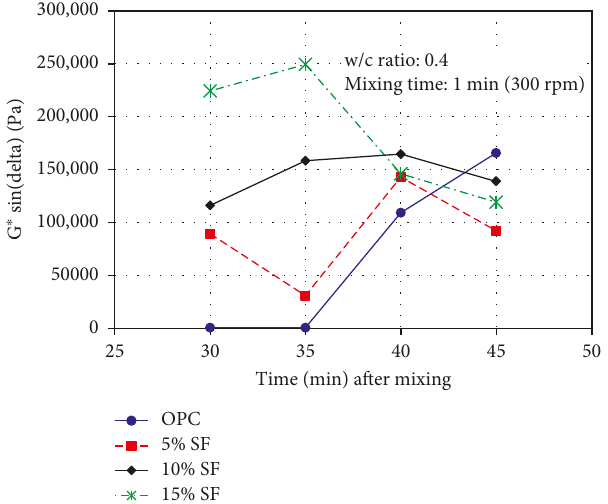
Figure 5: Viscosity with time after mixing (0.4w/c